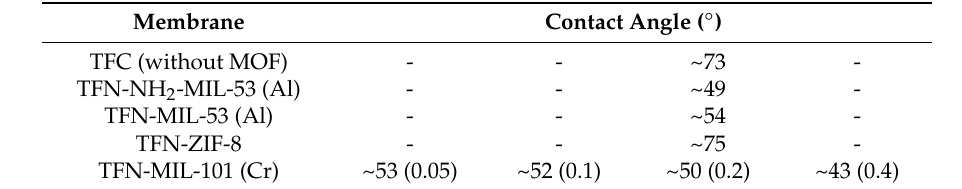
Table 2. Contact angle of thin film composite (TFC) and thin film nanocomposite MOF (TFN-MOF) membranes with 0.2% (w/v) concentration in the organic phase before Interfacial polymerization (IP) reaction. For TFN-MIL-101, concentration was changed from 0.05 to 0.4% (w/v); Reproduced with permission from [62].